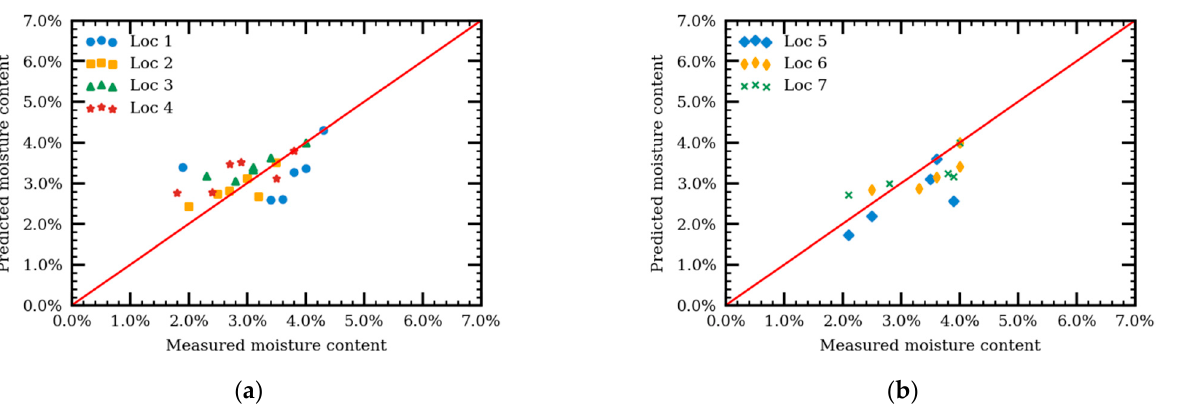
Figure 13. Comparisons between predicted and measured moisture contents for Locations 1–4 ( a ) and 5–7 ( b